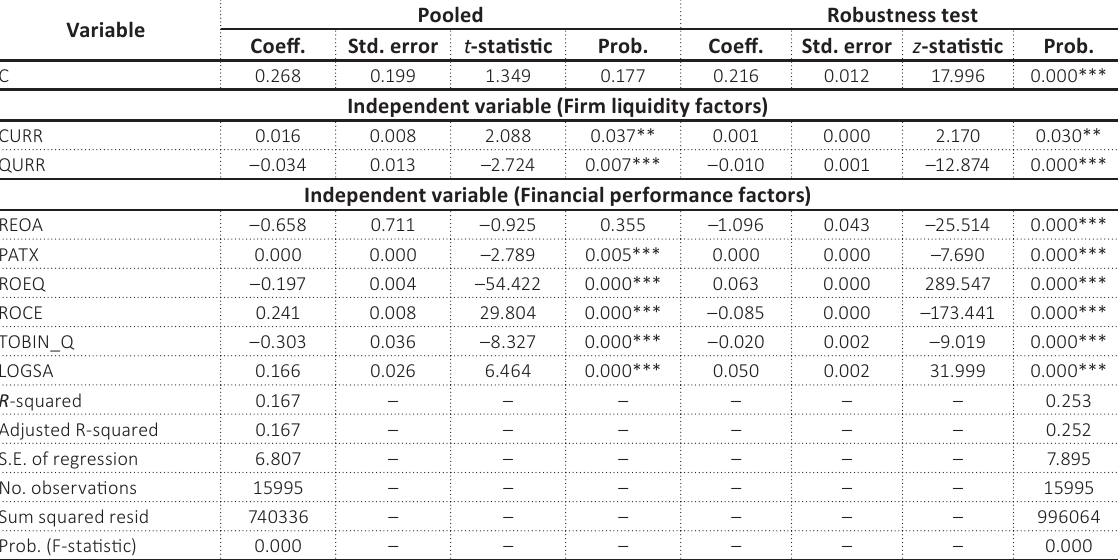
Table 7. Comparison of OLS and robust regression